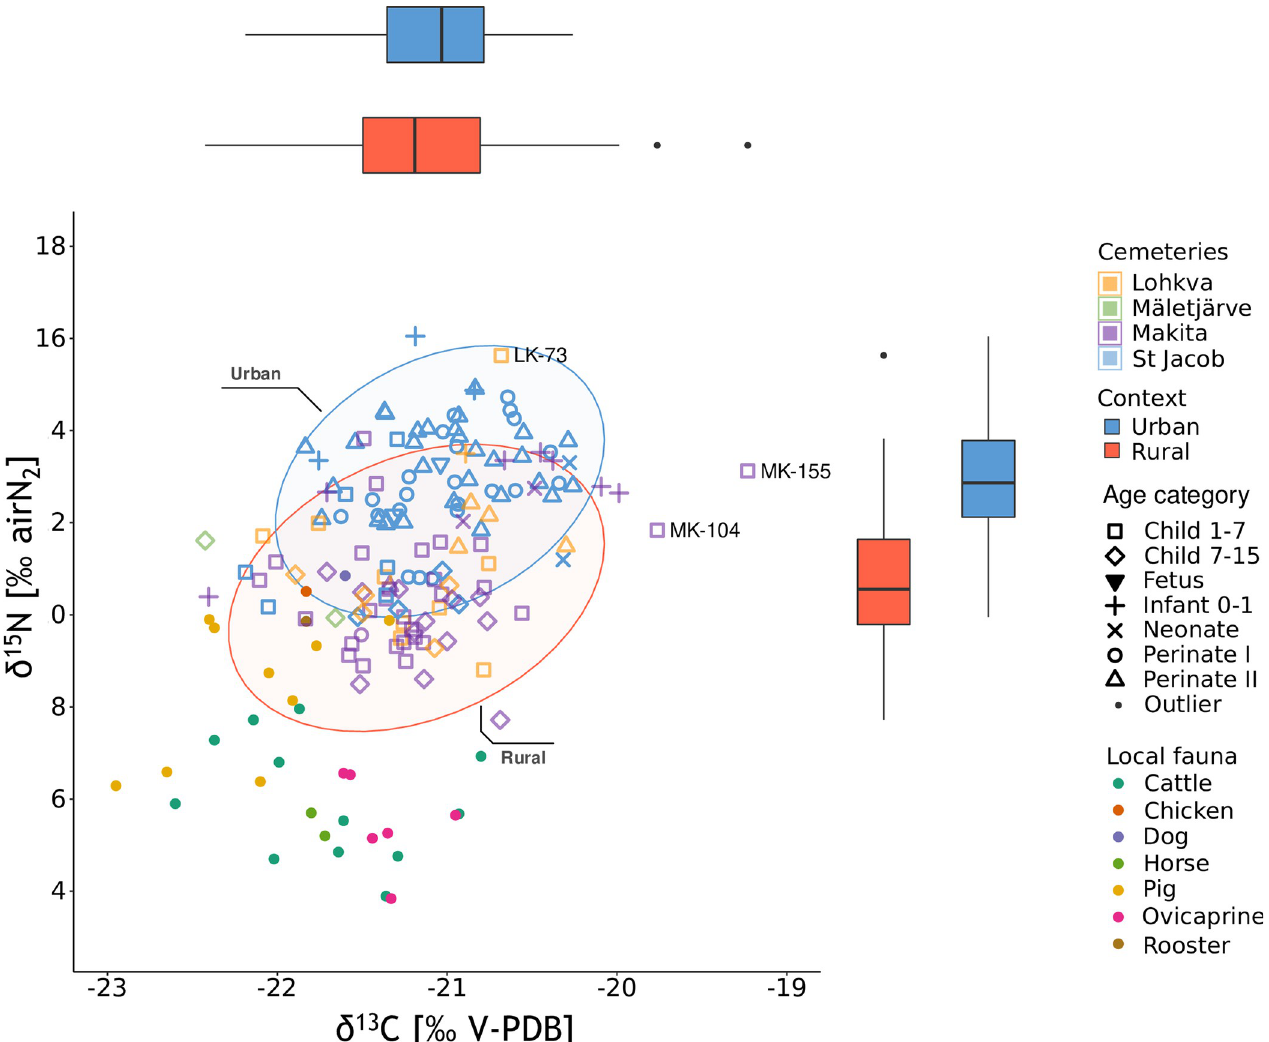
Fig 3. Carbon and nitrogen stable isotope values of the samples colored by the cemeteries used in this study. The urban and rural distributions are separated in the boxplots. The values of local fauna are added as references (Aguraiuja-La¨tti, original data; Malve, original data). The ellipses are drawn with 95% confidence intervals, and the outliers related to the urban and rural samples were determined using the IQR